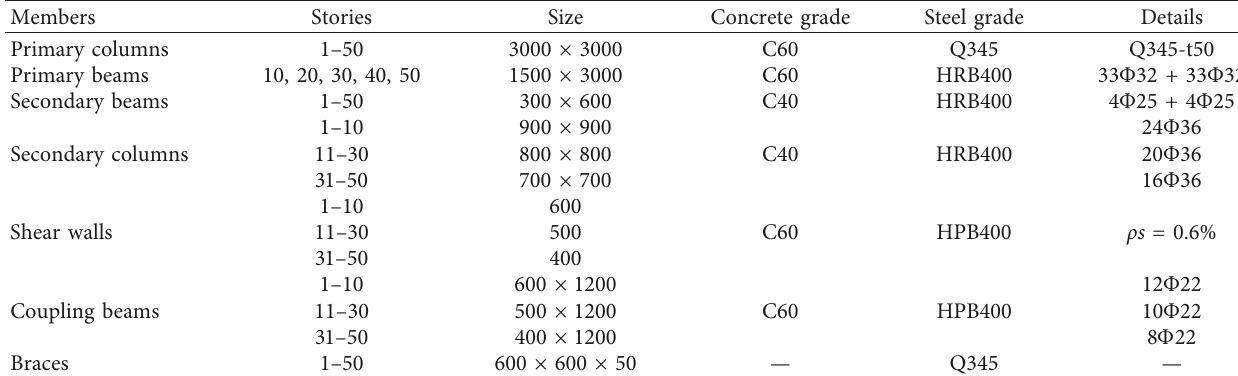
Table 1: Selected members for 50-story analysis structures (unit: